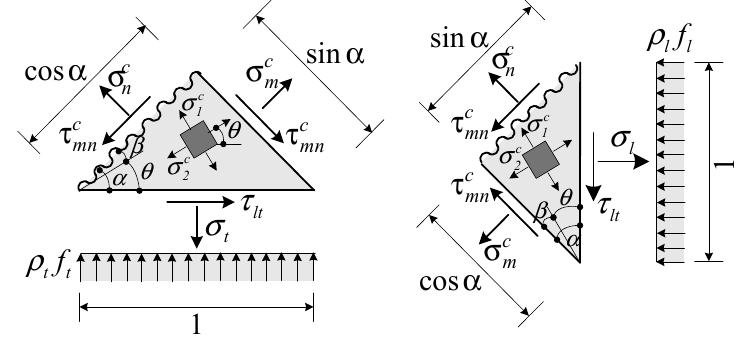
Figure 2. Stress state of shear critical element.